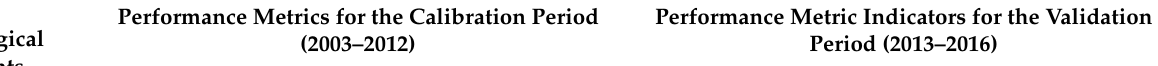
Figure 6. Water storage simulation by the VIC model both in the whole period ( k ) and the ten sliding window periods ( a – j ). Table 2. Overall VIC model performance in simulating runoff, evaporation, and water storage for the whole period over the southern Haihe river basin plain. (Note that ** indicates p < 0.01 and * indicates p < 0.05).